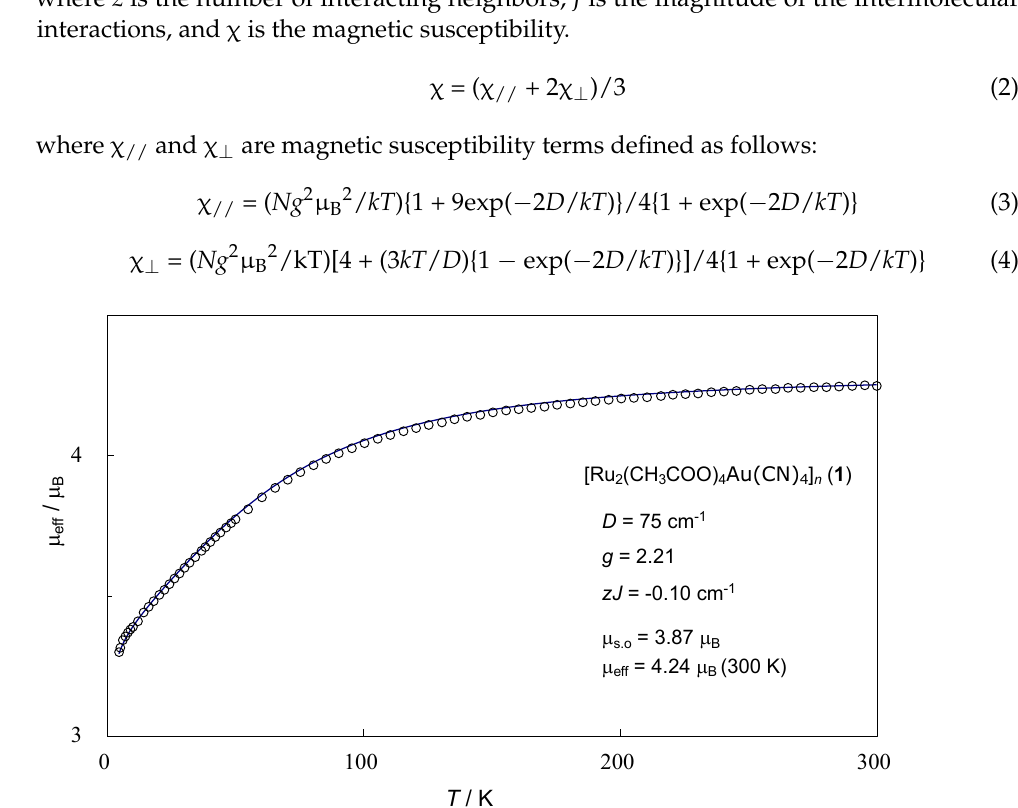
Figure 5. Variable temperature of magnetic moment µ eff for [Ru 2 (CH 3 COO) 4 Au(CN) 4 ] n ( 1 ). The solid black line was calculated and drawn with the parameter values described in the text.